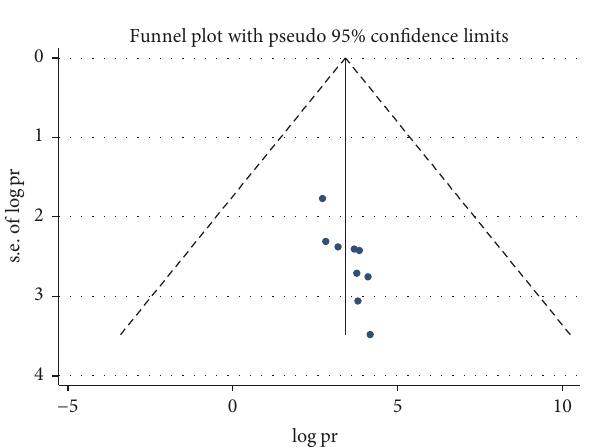
Figure 5: Result of trim and fill analysis for adjusting publication bias of the 9 studies,